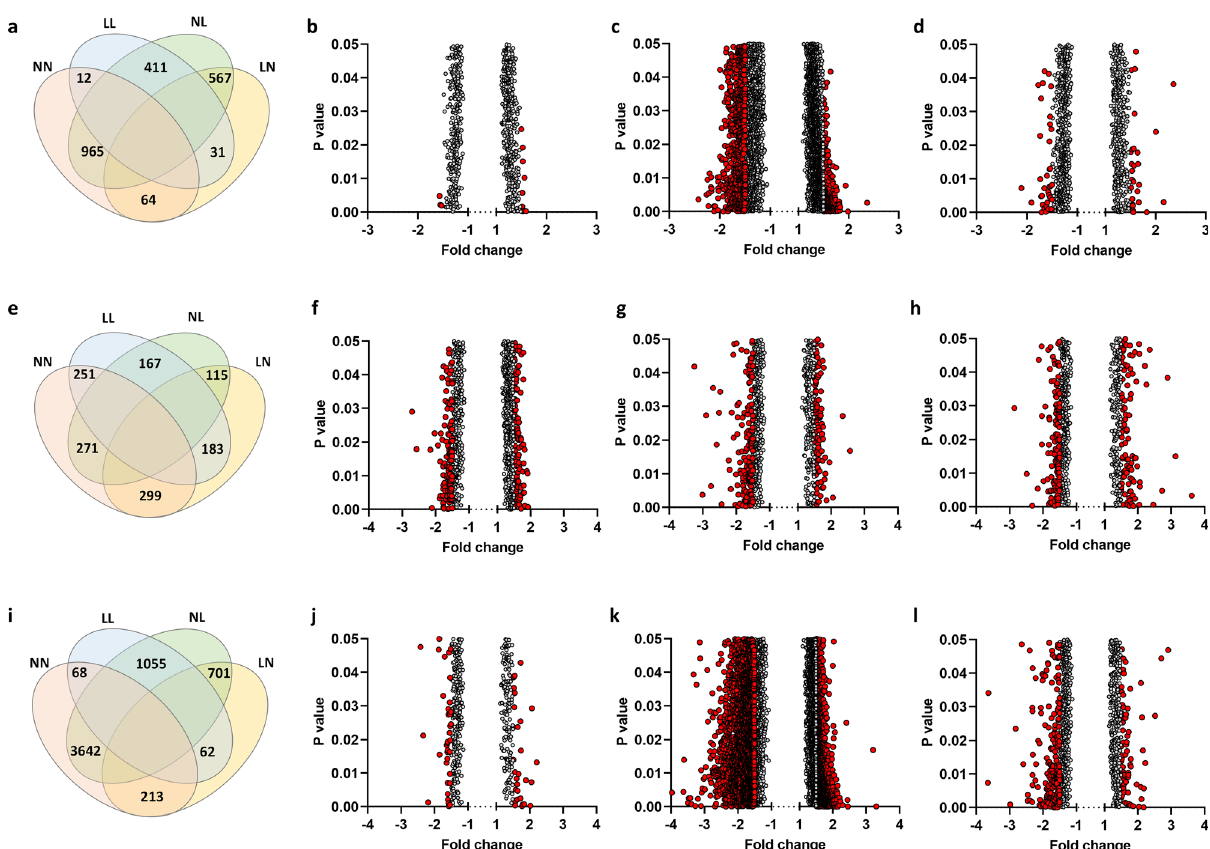
Fig. 3 Adult-offspring hepatic gene expression pro fi les. Analysis of adult (16 weeks) F1 offspring hepatic transcript pro fi les with a Venn diagram displaying number of genes with differential expression (>1.5 fold, either positive or negative) between adult (16 weeks of age) NN (NPD sperm and NPD seminal plasma), LL (LPD sperm and LPD seminal plasma), NL (NPD sperm and LPD seminal plasma) and LN (LPD sperm and NPD seminal plasma) offspring liver. Volcano plot of differential genes (>1.5 fold, either positive or negative) between b NN and LL adult offspring, c NN and NL offspring and d NN and LN offspring. e Venn diagram displaying number of genes with differential expression (>1.5 fold, either positive or negative) between adult (16 weeks of age) NN (NPD sperm and LPD seminal plasma), LL (LPD sperm and LPD seminal plasma), NL (NPD sperm and LPD seminal plasma) and LN (LPD sperm and NPD seminal plasma) female offspring liver. Volcano plot of differential genes (>1.5 fold, either positive or negative) between f NN and LL adult females, g NN and NL adult f emales and h NN and LN adult females. i Venn diagram displaying number of genes w i th differential expression (>1.5 fold, either positive or negative) between adult (16 weeks of age) NN (NPD sperm and LPD seminal plasma), LL (LPD sperm and LPD seminal plasma), NL (NPD sperm and LPD seminal plasma) and LN (LPD sperm and NPD seminal plasma) male offspring liver. Volcano plot of differential genes (>1.5 fold, either positive or negative) between j NN and LL adult males, k NN and NL adult males and l NN and LN adult males. N = 4 males and 4 females, each from separate litters. Statistical differences were determined by one-way ANOVA with Partek ® Genomics Suite ® analysis